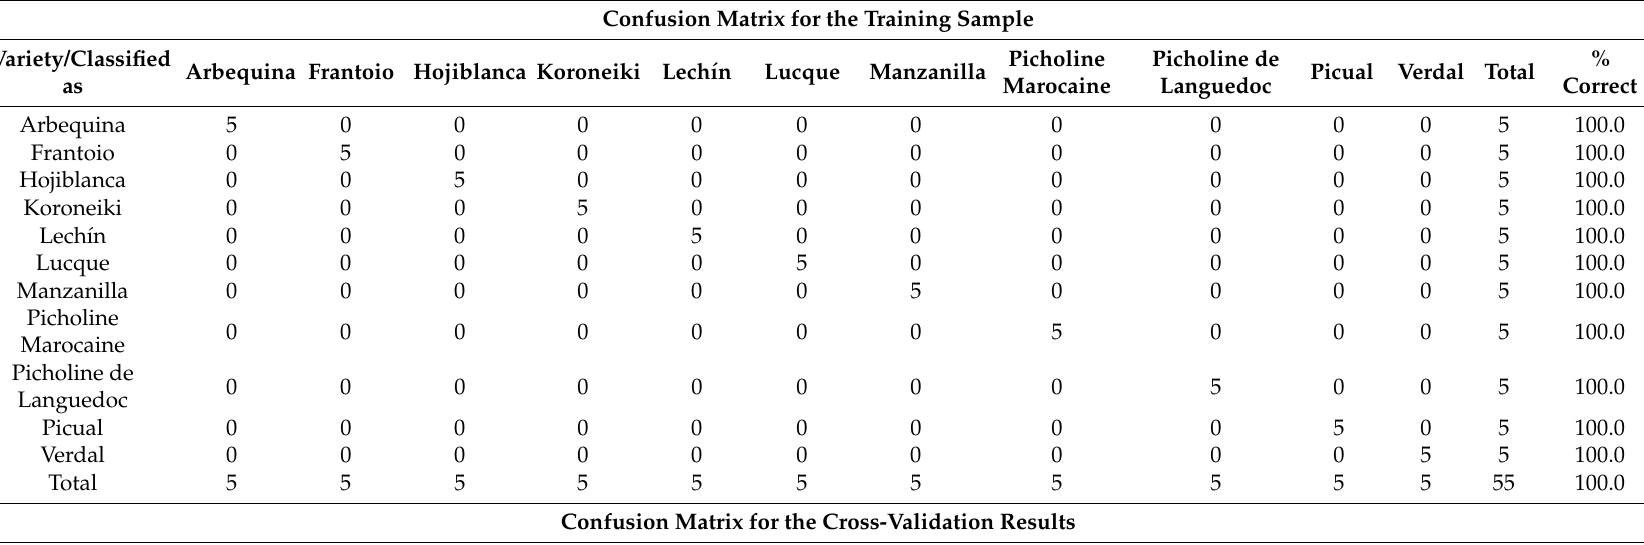
Table 5. Classification and Prediction ability results of s-LDA model, based on olive leaves phenolic composition, for achieving varietal origin separation. Confusion Matrix for the Training